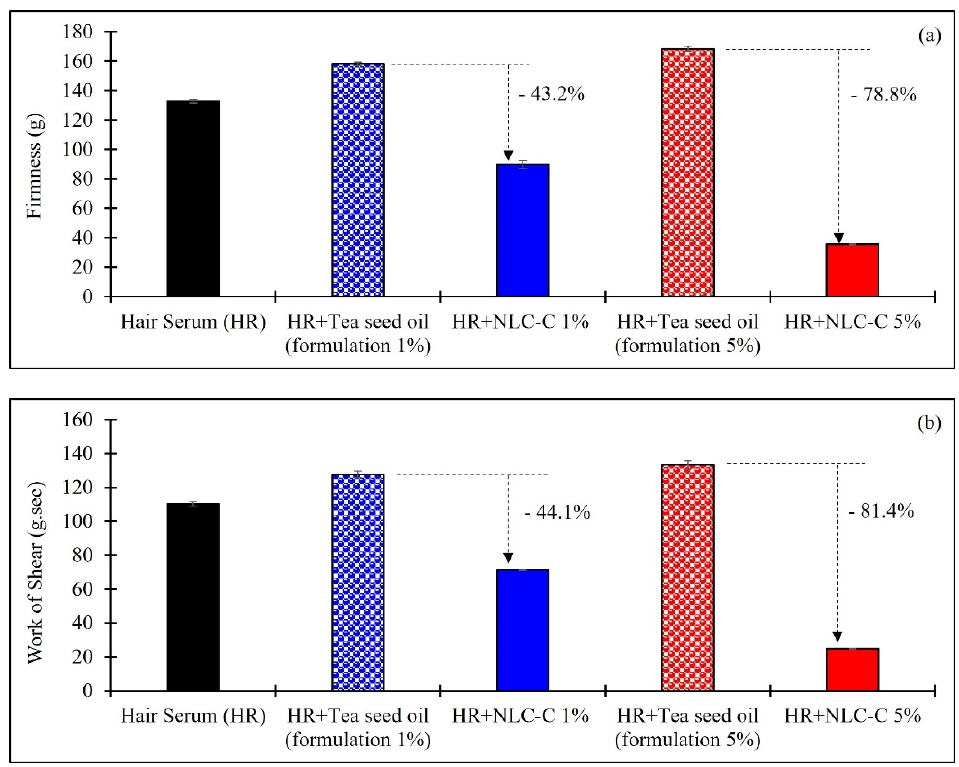
Figure 8 . Firmness ( a ), work of shear ( b ) of various samples using a texture analyzer. Figure 8. Firmness ( a ), work of shear ( b ) of various samples using a texture